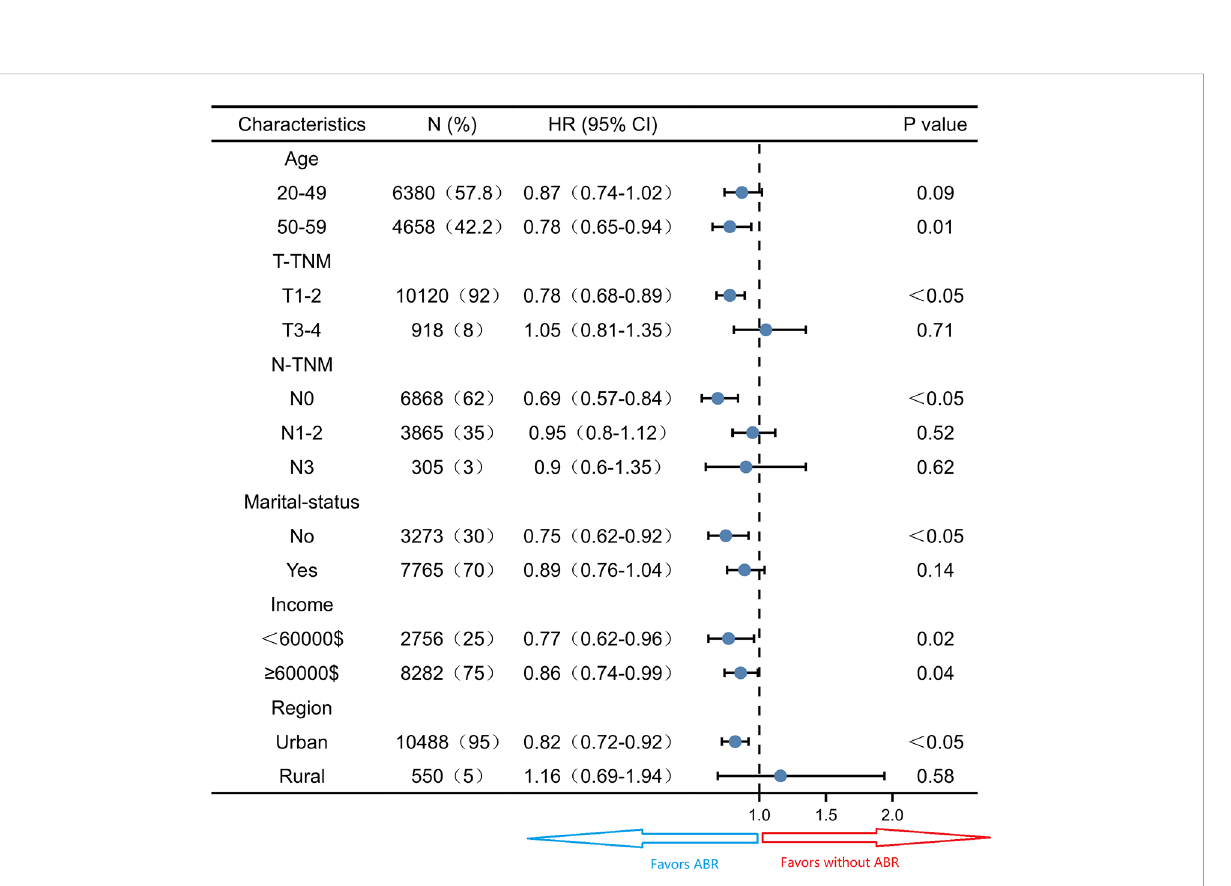
FIGURE 3 Subgroup analysis of overall survival in propensity score matched cohort (N =